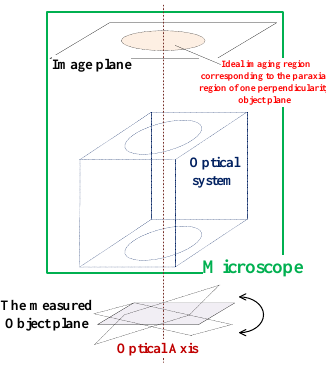
Figure 1. The measured object plane is perpendicular to the optical axis of the microscopic system.